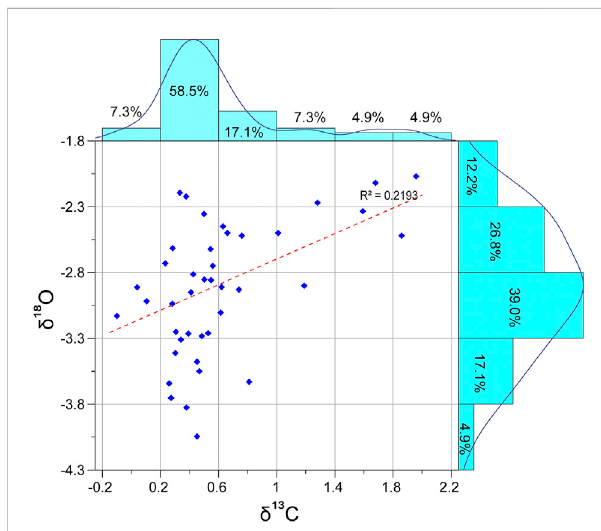
FIGURE 5 Histograms illustrating the distribution of the δ 13 C versus δ 18 O data. The cross-plots show a weak correlation ( R 2 = 0.219).